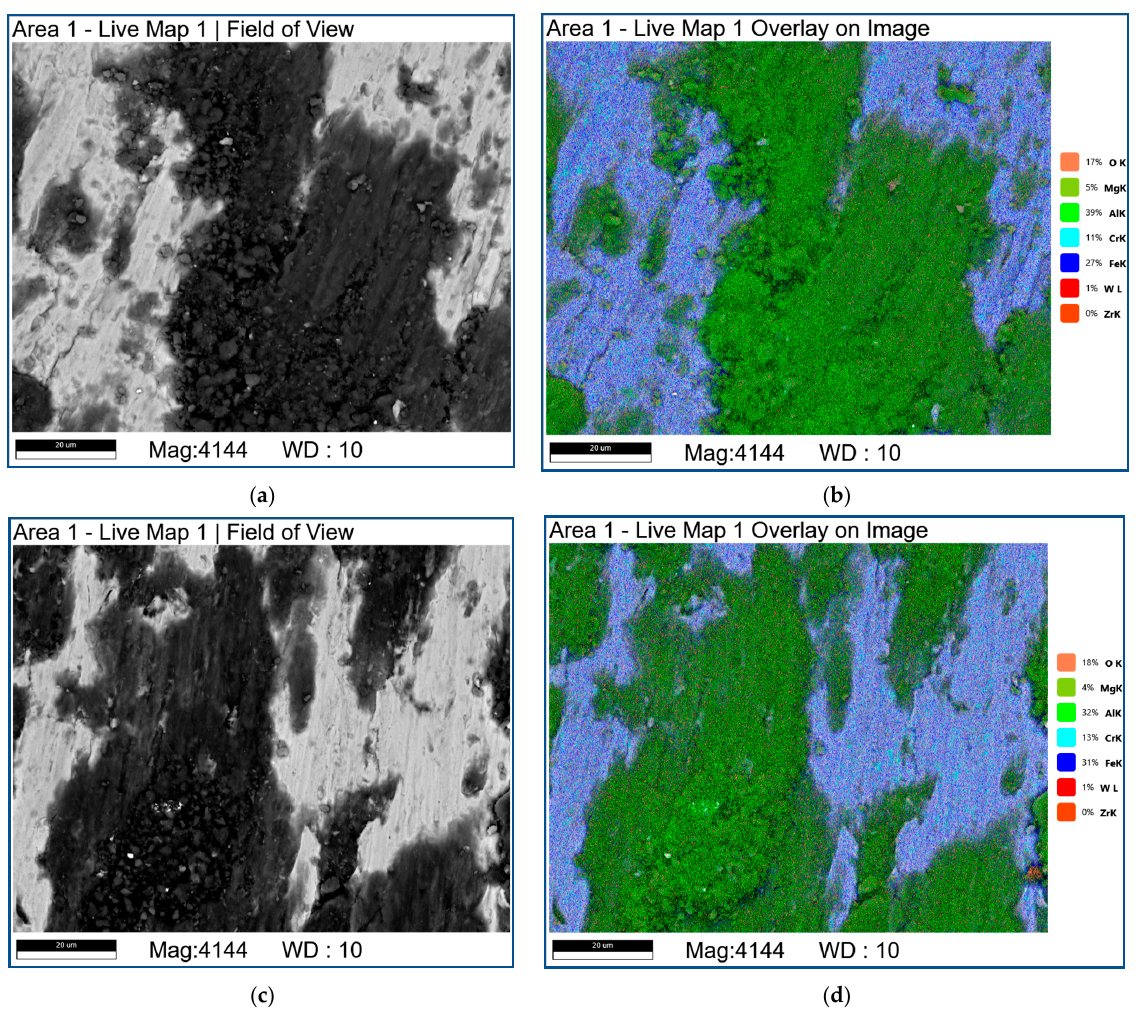
Figure 23. SEM BSE image ( a , c ) and combined EDS images ( b , d ) on the worn surface of FSP-ed RPPs/AA5056 composite after: 4 passes ( a , b ); 8 passes ( c , d ). There are bright particles on the worn surfaces that contain W, Zr and O (Figure 24; Table 4, pos. 1) and the same particles can be observed in Figure 24a, pos. 1 ′ directly below the worn surface in the bulk of the composite.